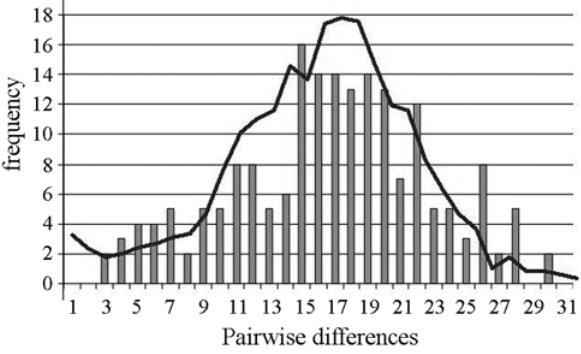
Figure 6 - Mismatch distribution analysis for the Belize population. The line shows the expected distribution under the null hypothesis of popula- tion expansion.